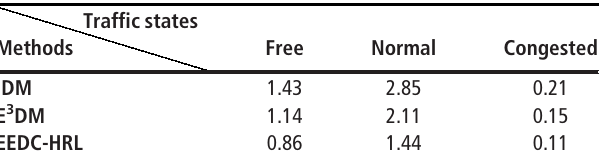
Table 4 Average number of lane changing in different traf fi c states for the three